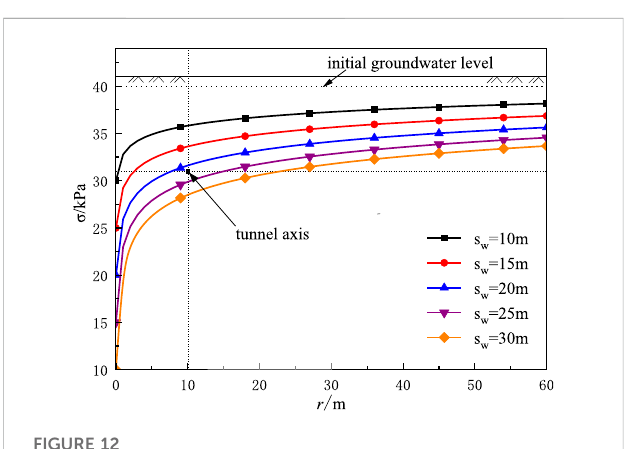
FIGURE 14 Curves of tunnel displacement under different water level drawdown s